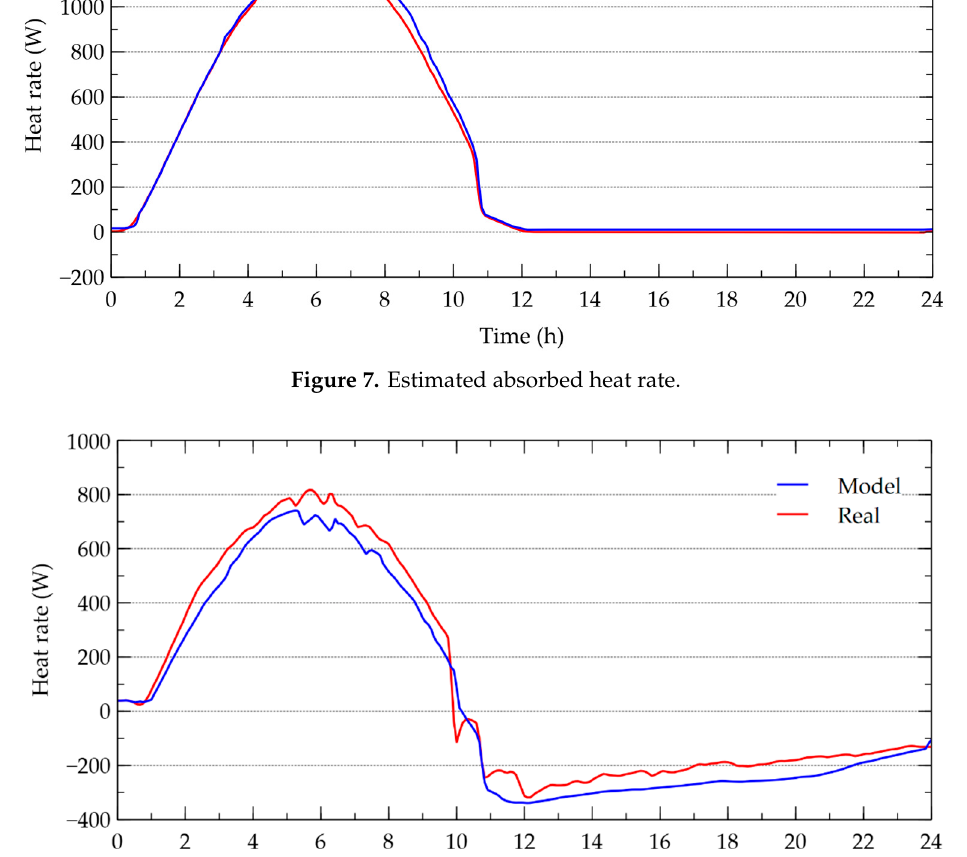
Figure 8. Estimated stored heat rate.